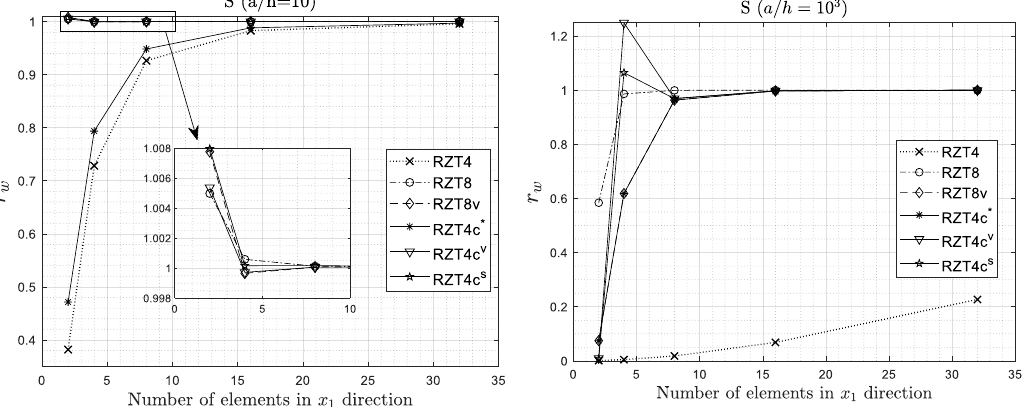
Figure 9. Convergence analysis of the FEM solution for the sandwich plate (S). Regular mesh.